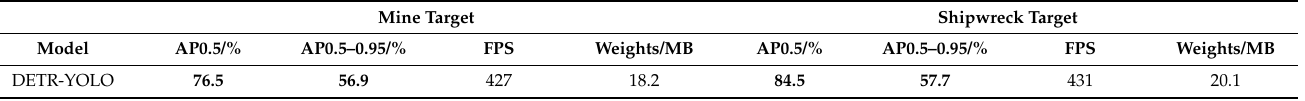
Table 2. Detection performances of the DETR-YOLO